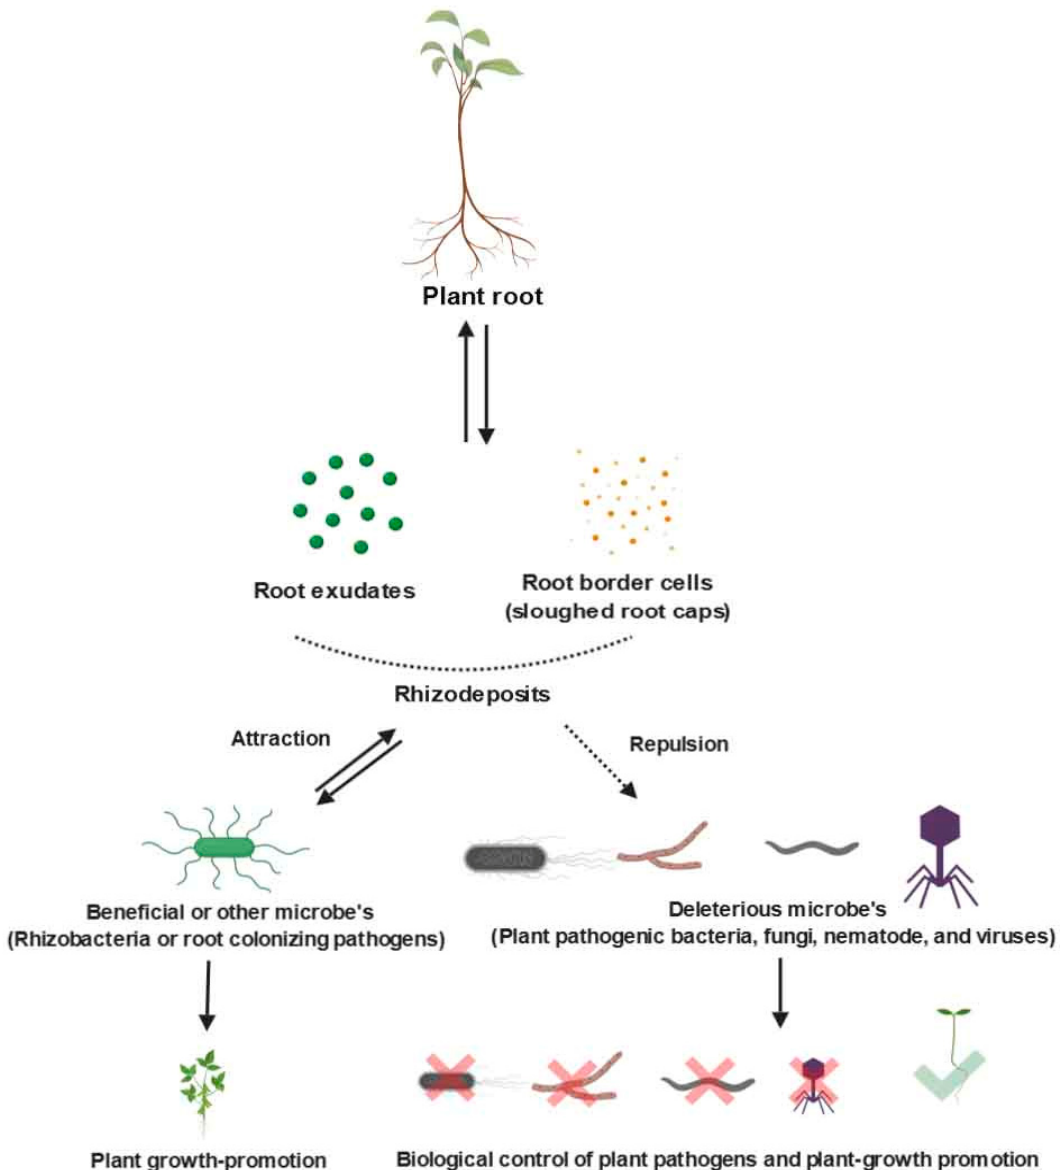
Figure 2. Interactions between bioactive organic compounds secreted by plant roots and beneficial or deleterious microbes resulting in attraction or repulsion (created with Biorender.com).